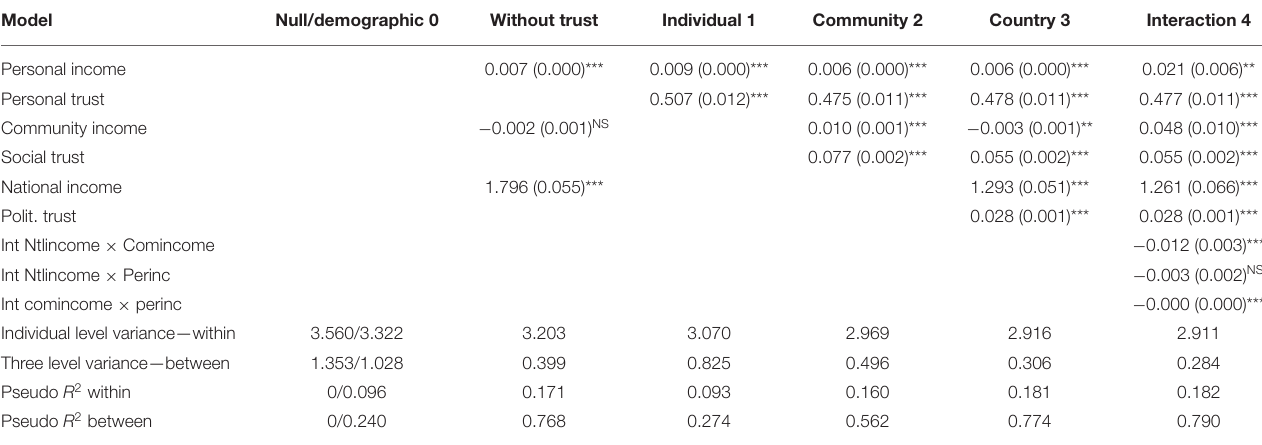
TABLE 3 | Results [fixed effects (Beta (SE)sig) and pseudo R 2 (explained variance) for four models of multilevel analysis of personal life satisfaction against personal trust and personal income (model 1); against personal parameters and additionally social trust and community income (model 2); the preceding parameters and additionally against political trust and national income (model 3); and finally the preceding parameters with the three interactions of all three income parameters, indicating a layer effect (model